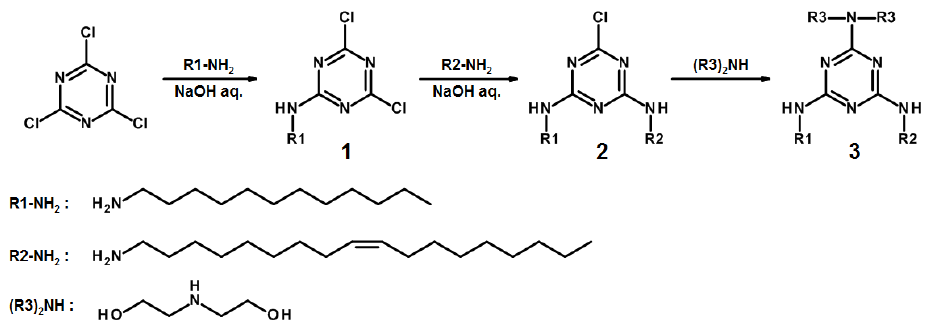
Figure 5. Synthesis of the pH-sensitive lipidoid ( 3 ).